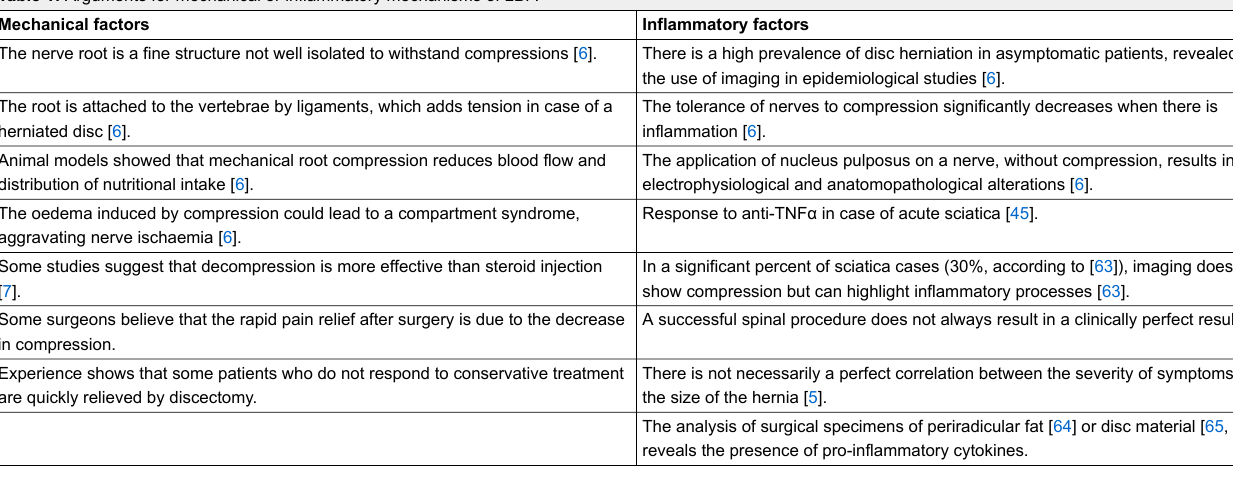
Table 1: Arguments for mechanical or inflammatory mechanisms of LBP. Mechanical factors Inflammatory factors